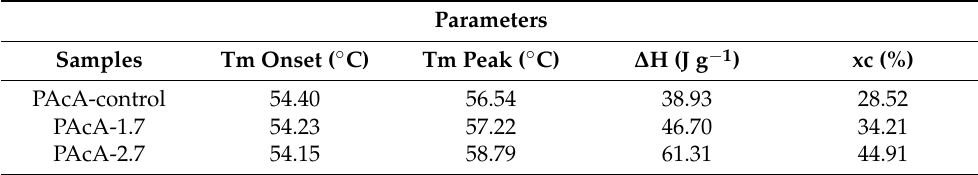
Table 6. DSC curves parameters of the PCL casting films: onset melting temperature (Tm onset), peak melting temperature (Tm peak), enthalpy for melting ( ∆ H), and degree of crystallinity (xc%).